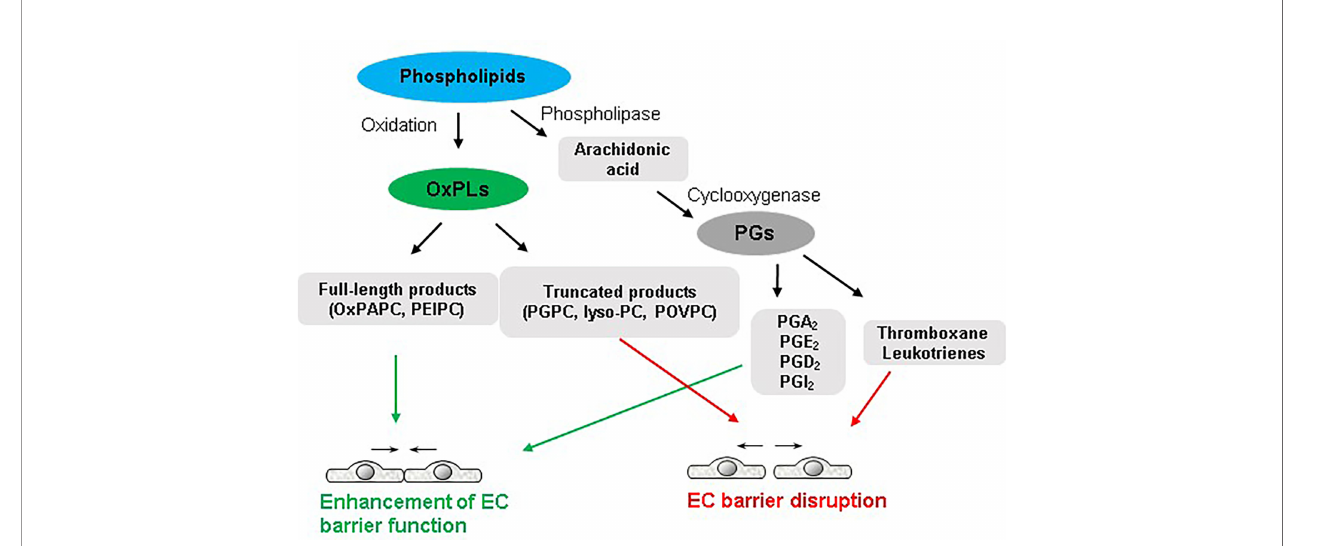
FIGURE 1 | Dual role of phospholipids in endothelial function. Full-length oxidized products of phospholipids and some groups of PGs enhance endothelial barrier integrity. In turn, truncated OxPLs and some products of arachidonic acid such as thromboxane and leukotrienes disrupt endothelial